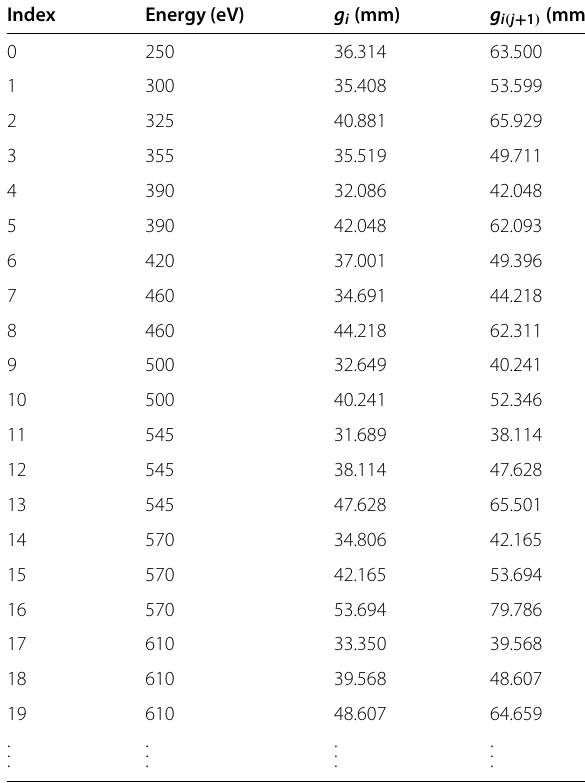
Table 6 Pairs of PS1 gaps giving phase difference of 2 π at a given energy obtained from the PS optimization with ID1 and ID3